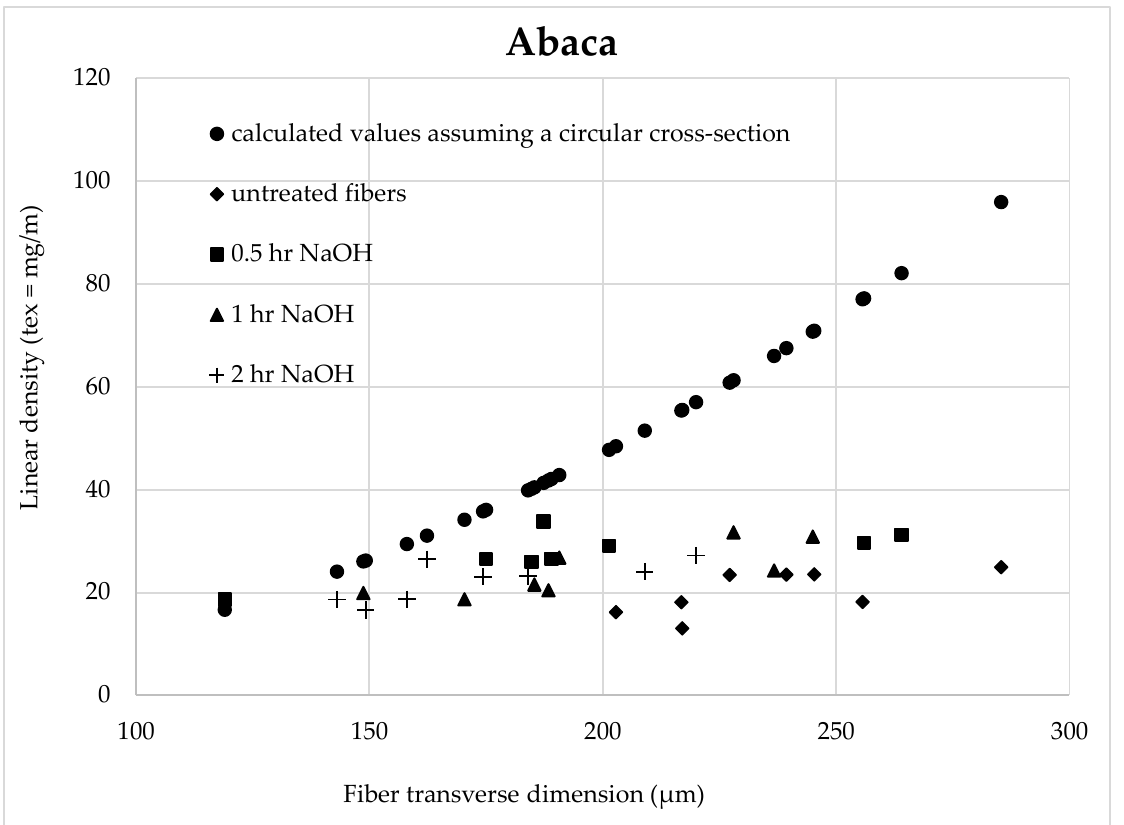
Figure 14. Dependence of the linear density on the transverse dimension of the abaca fiber.